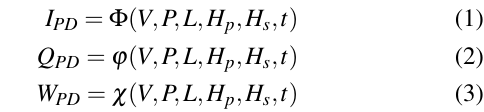
age V , (ii) SF 6 pressure P , (iii) particle length L , (iv)